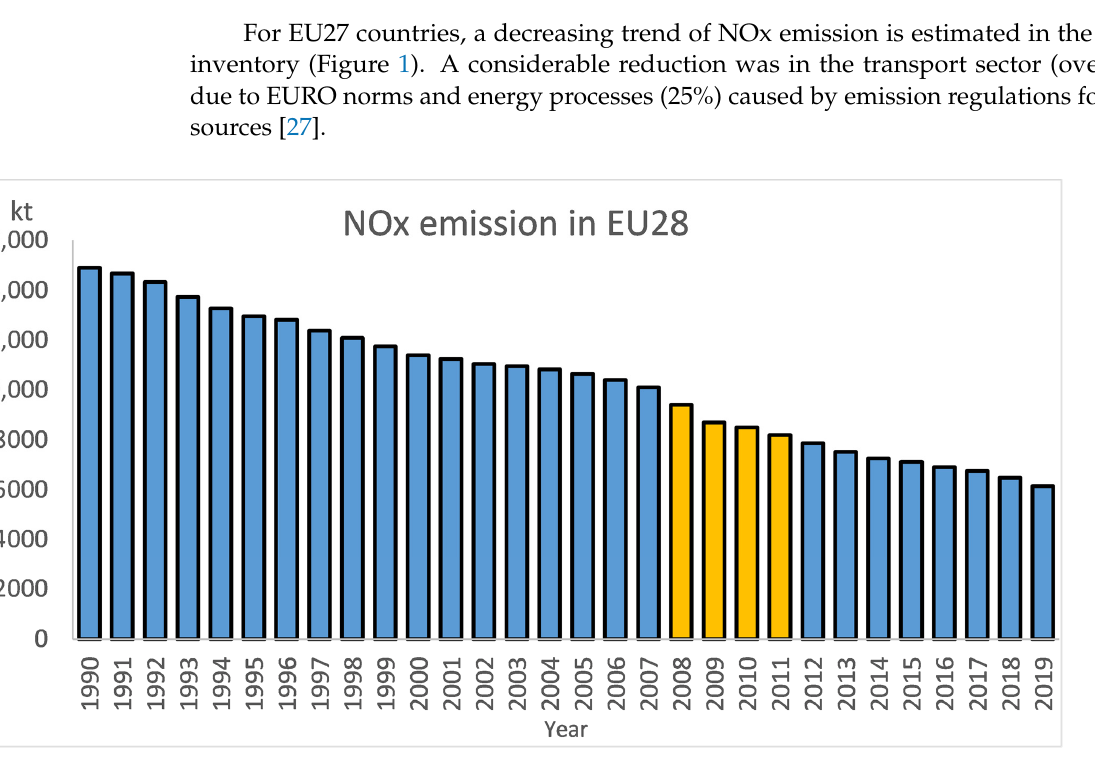
Figure 2. Emissions of nitrogen oxides NOx as NO 2 for EU28 ( A ) and Poland ( B ) divided into different SNAP97 sectors, based on the EMEP database for the period 2008–2010. 0% 10%20%30% 40% S01 S02 S03 S04 S05 S06 S07 S08 S09 S10 S11 (A)